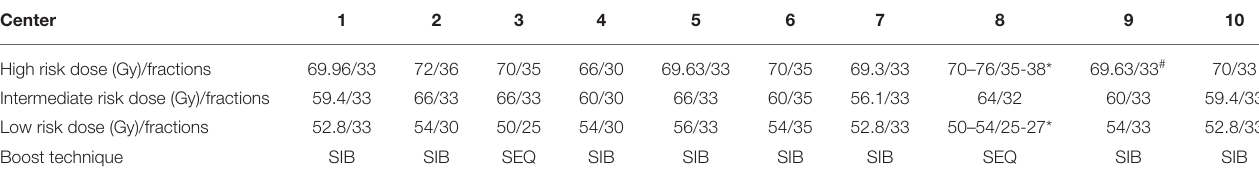
TABLE 1 | Dose-fractionation schedules for definitive